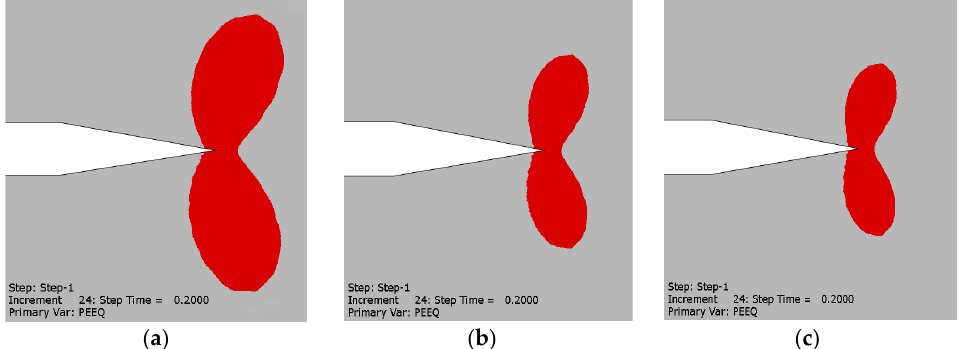
Figure 5. Effect of pre-strain on the cyclic plastic zone at the crack tip after the first cycle: ( a ) 0%; ( b ) 2%; ( c ) 4%.